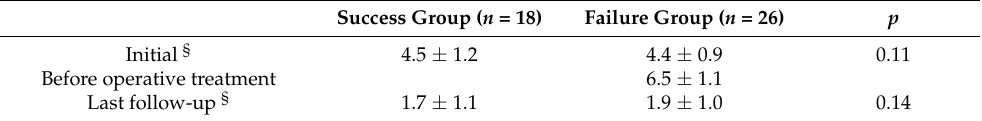
Table 3. VAS changes of the patients.